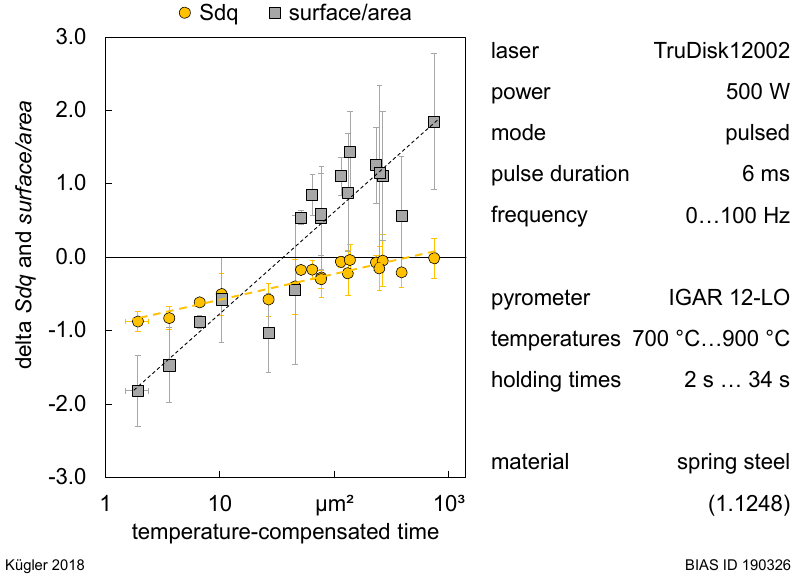
Figure 6. Roughness value Sdq and topography factor surface/area of laser-heated 1.1248 sheets.